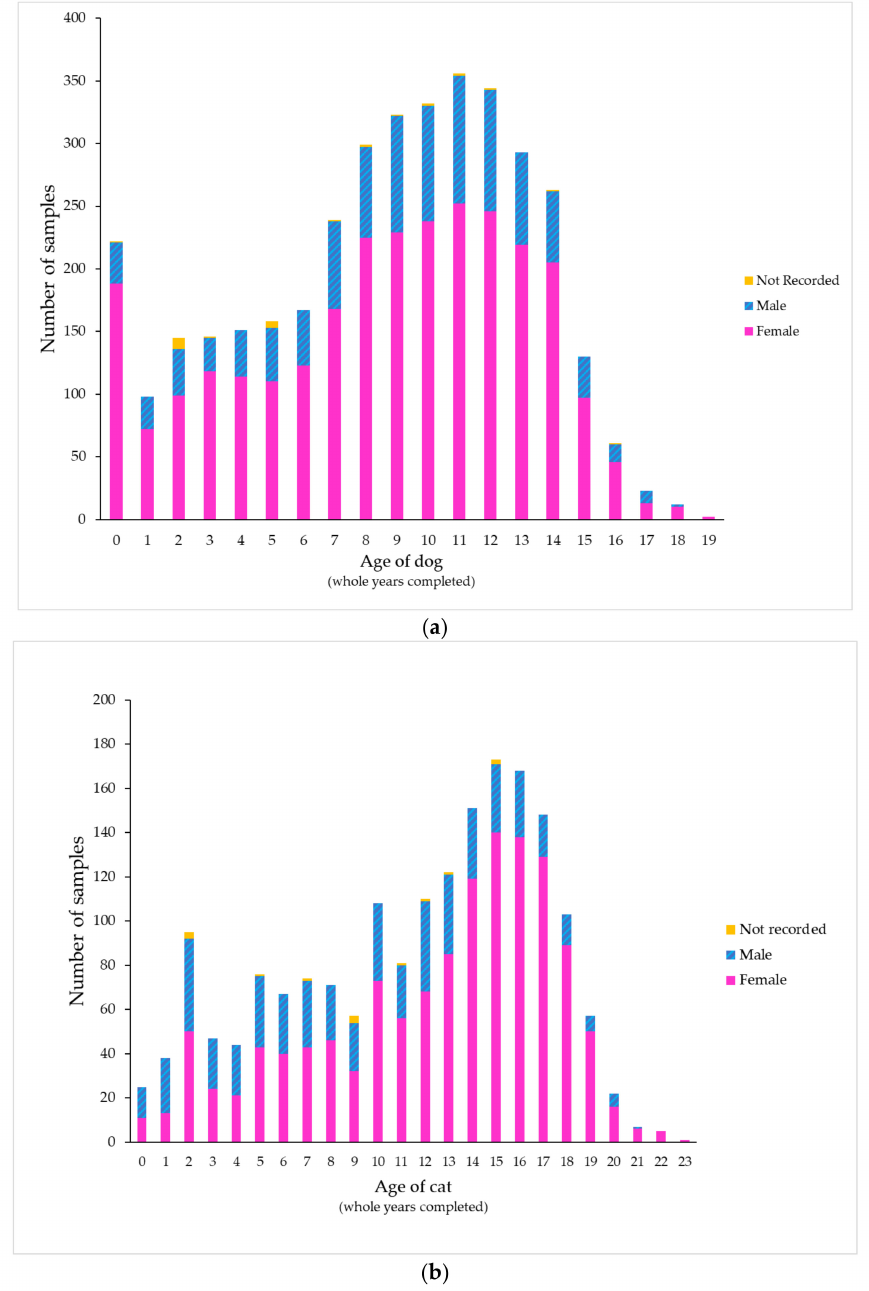
Figure 1. Distribution of samples by patient age and sex in ( a ) dogs and ( b )